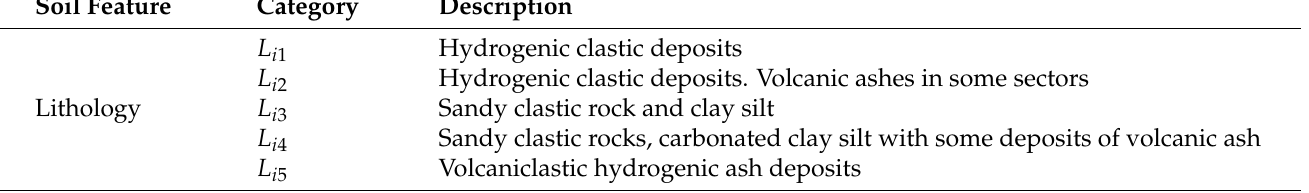
Table 5. Categories of the soil features of the case